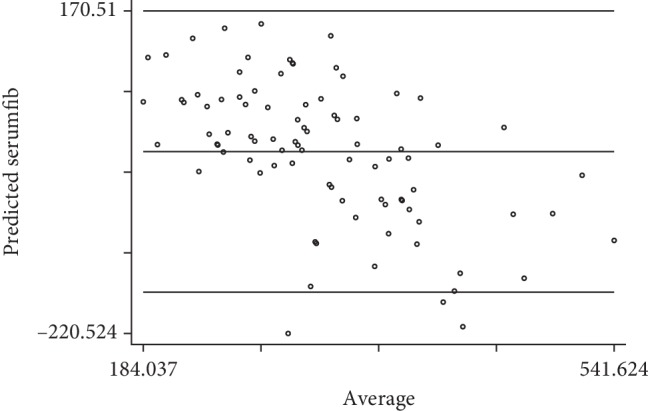
The Bland–Altman plot between predicted values and actual values of fibrinogen level.